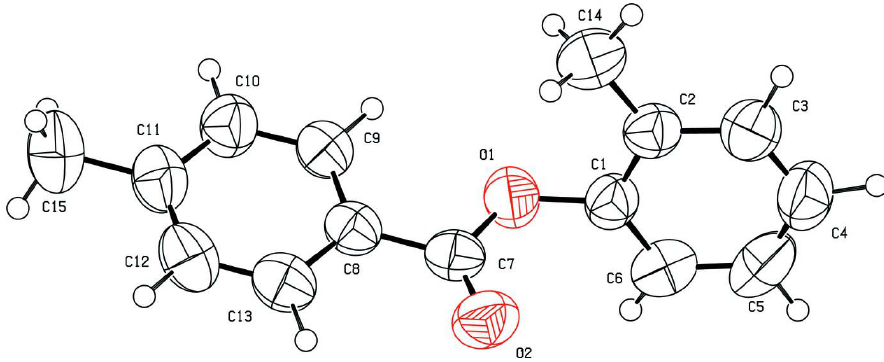
Figure 1 Molecular structure of the title compound, showing the atom labeling scheme. The displacement ellipsoids are drawn at the 50% probability level. The H atoms are represented as small spheres of arbitrary radii.